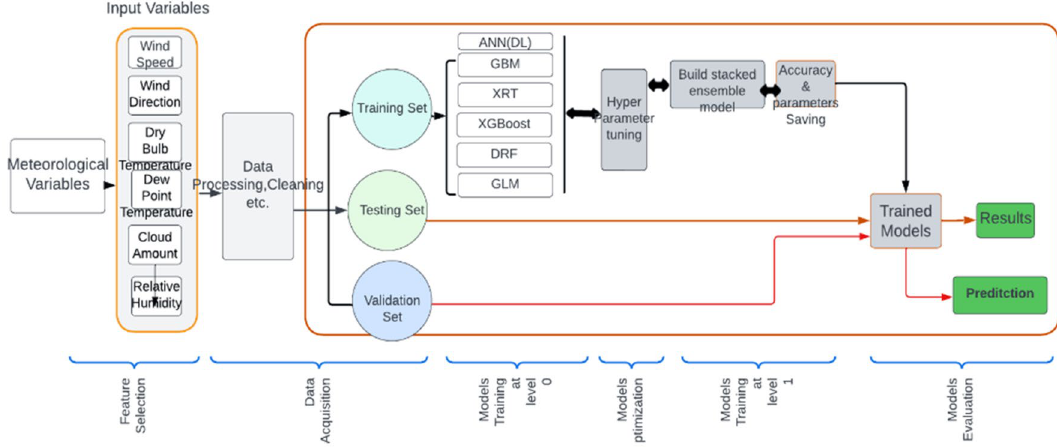
Fig. 2 Process block diagram of the proposed machine learning prediction